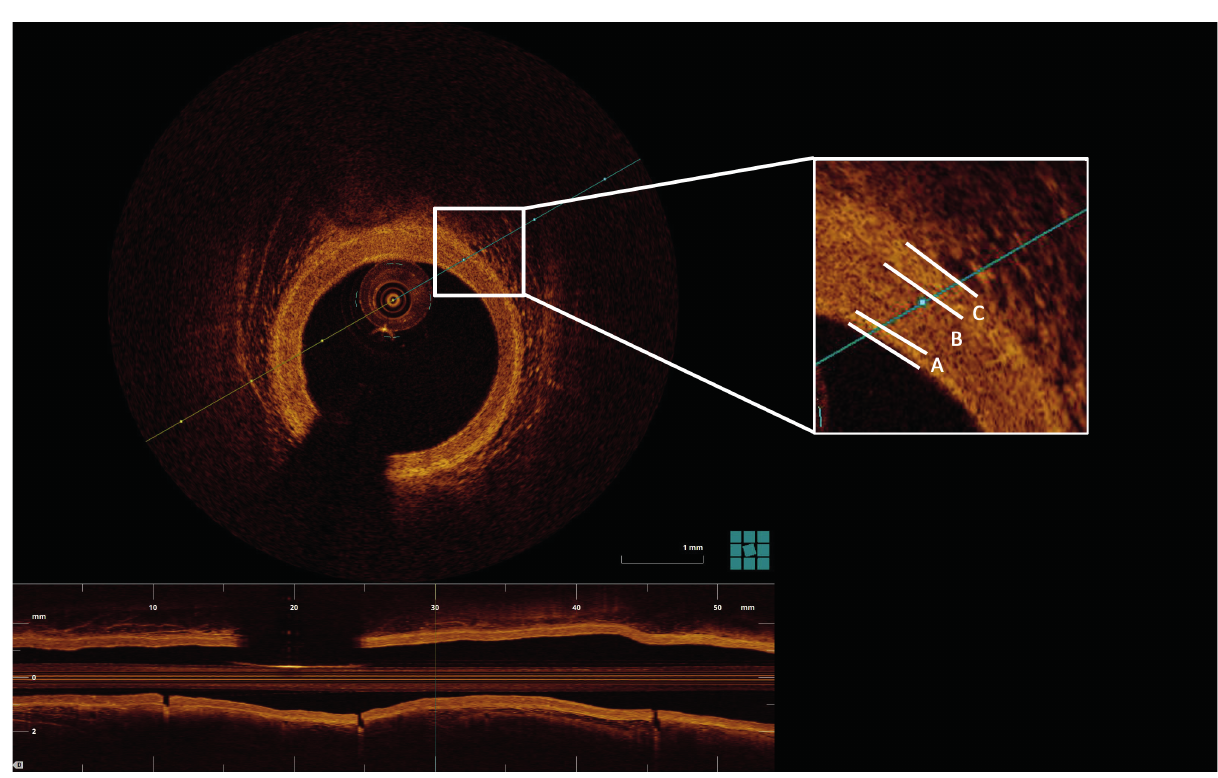
Fig. 1. representative ocT crossection of normal radial artery. a-intimal layer, B-media, c-adventitia